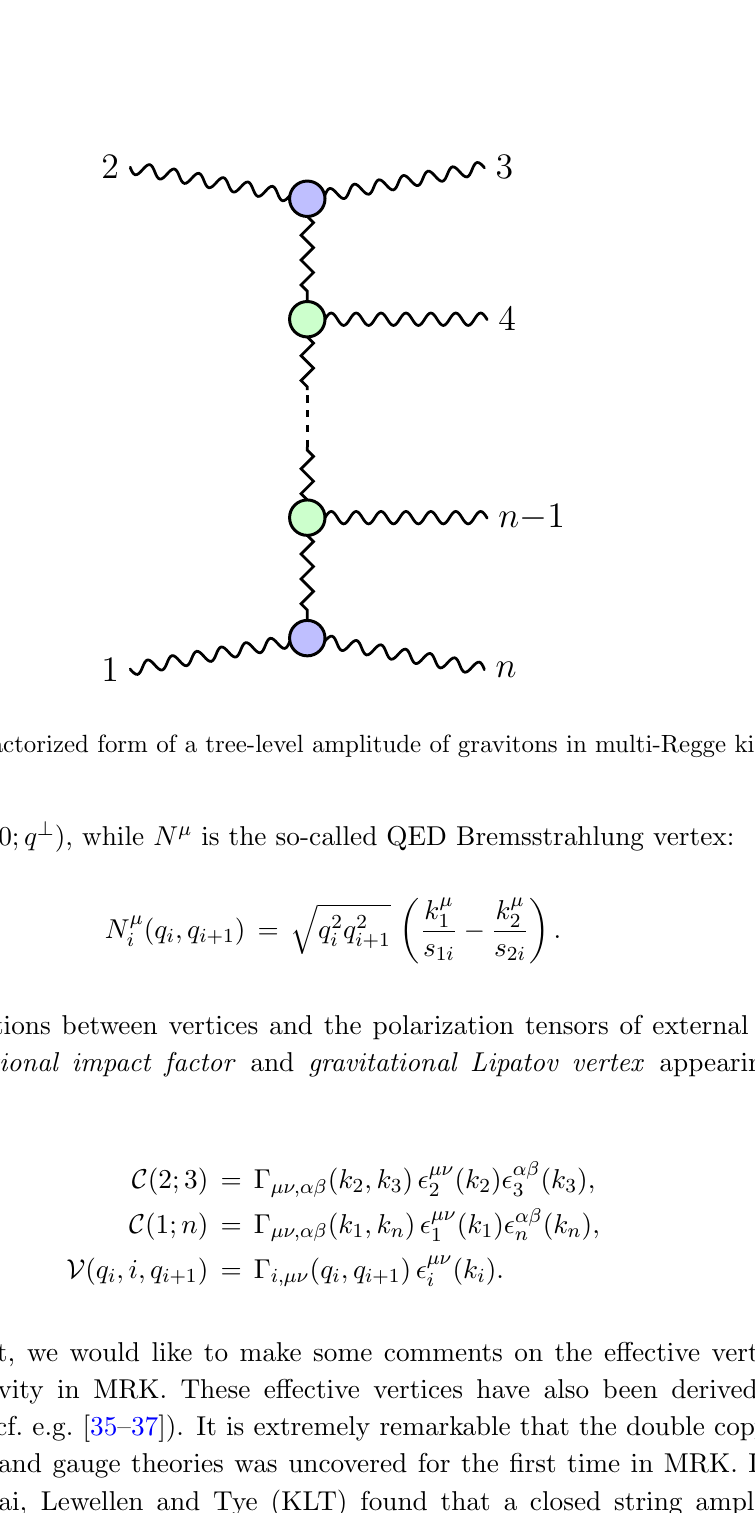
with ( q ⊥ ) µ (0 , 0; q ⊥ ), while N µ is the so-called QED Bremsstrahlung ≡